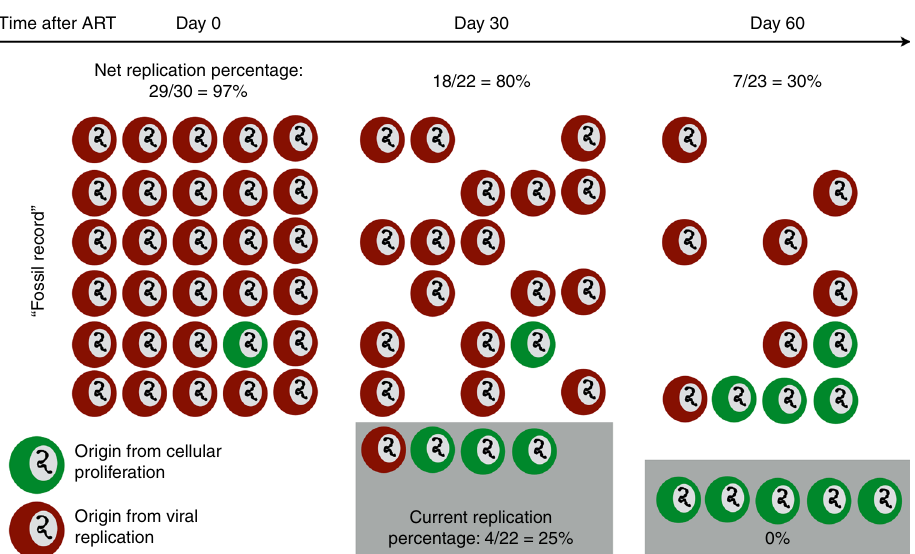
Fig. 8 Qualitative illustration of the fossil record phenomenon. In an example population of 30 infected cells, the proportion of infected cells that were once generated by HIV replication (the net replication percentage, or fossil record of HIV replication) remains >30% for the fi rst 2 months of ART. However, in this time, the proportion of cells newly generated by HIV replication (current, shaded box) becomes negligible. The net fraction is observed experimentally, so our simulations indicate a contemporaneous representation of the HIV reservoir cannot be observed until the fossil record is completely washed out, sometime between 6 months and a year of ART